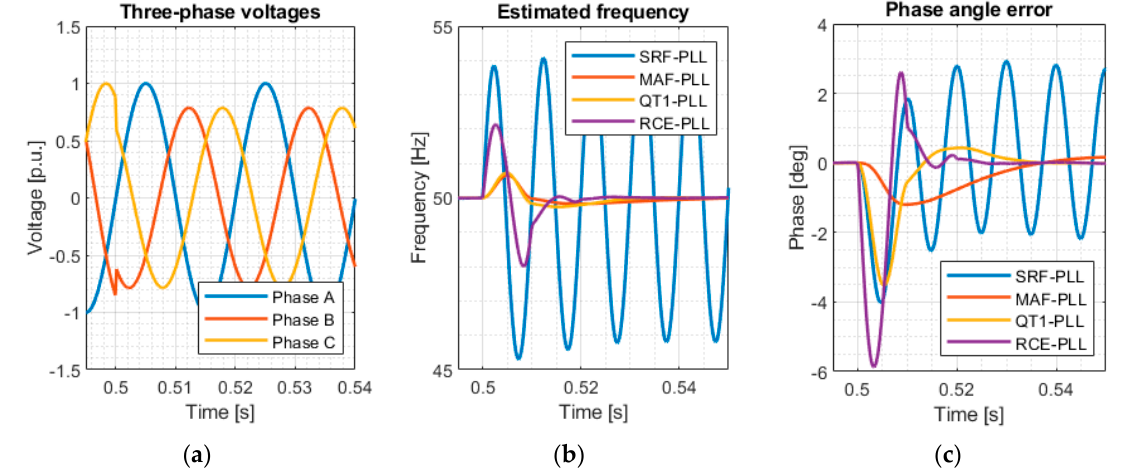
Figure 12. Voltage sag Type C, depth 0.7 test. ( a ) Grid voltage waveforms; ( b ) estimated grid frequency; ( c ) phase angle error.